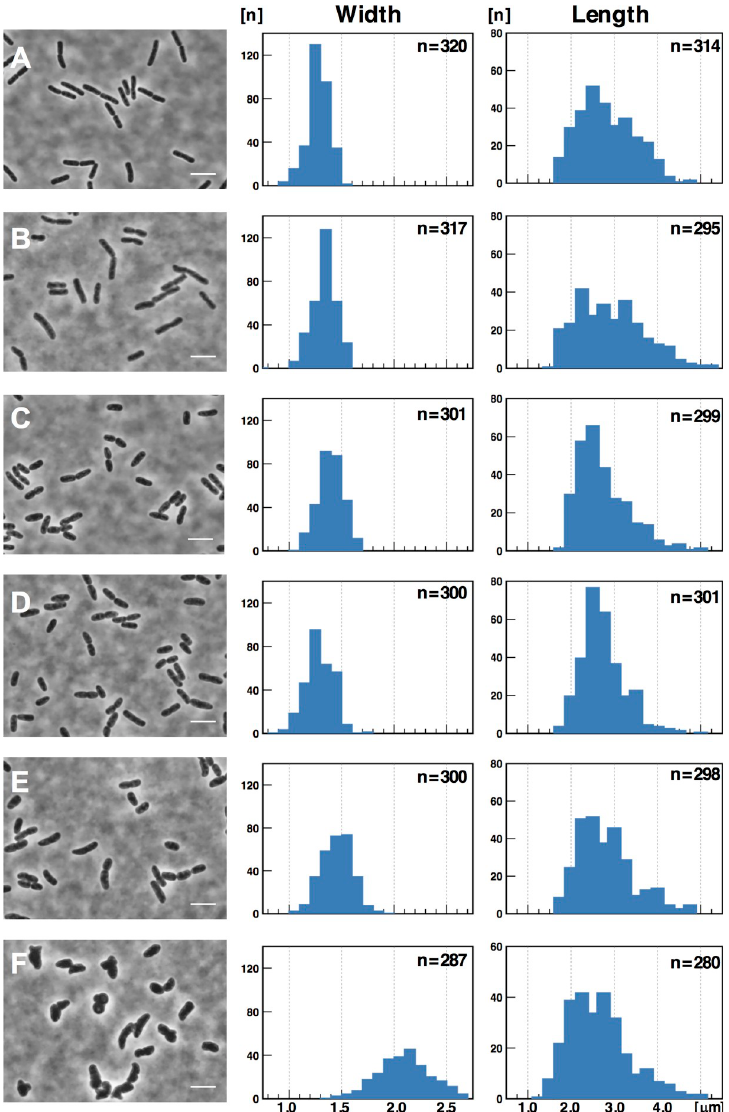
Fig 5. Shapes of the Δ rodZ mutant expressing RodZ cysteine-substitution mutants. (A) wild-type strain MS390. Δ rodZ strain carrying: (B) pBAD-rodZ wt (MS5215); (C) pBAD-rodZ C38S (MS5242); (D) pBAD-rodZ C263S (MS5243); (E) pBAD-rodZ C38S, C263S (MS5244); or (F) pBAD18-Kan (MS5204). Strains were grown to OD 600 = 0.4 in 5-ml LB medium containing 25 μ M arabinose and kanamycin at 30˚C with shaking (150 rpm) for 2.5 hrs. Cells were fixed with 1.0% formaldehyde and observed using a phase-contrast microscope. Scale bar = 5 μ m. The length distributions were analyzed using two tailed Student’s t test. Significance (p < 0.05) differences were observed between all combinations of width and length, except for the combinations of lengths as follows: (C) and (D); (D) and (E); (C) and (E). Results are combination of three independent experiments.